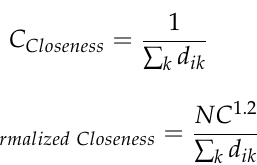
Figure 17. Elbow method illustrating the relationship between the number of clusters k and the total within-clusters variation. The vertical line indicates minimal number of clusters. The black vertical line indicates the chosen number of clusters. Even though, the four clusters are sufficient from the quantitative point of view, we identified experimentally that a higher number of clusters more appropriately reflects the established urban typology classification. This distinguishes between building types, such as detached, semidetached,